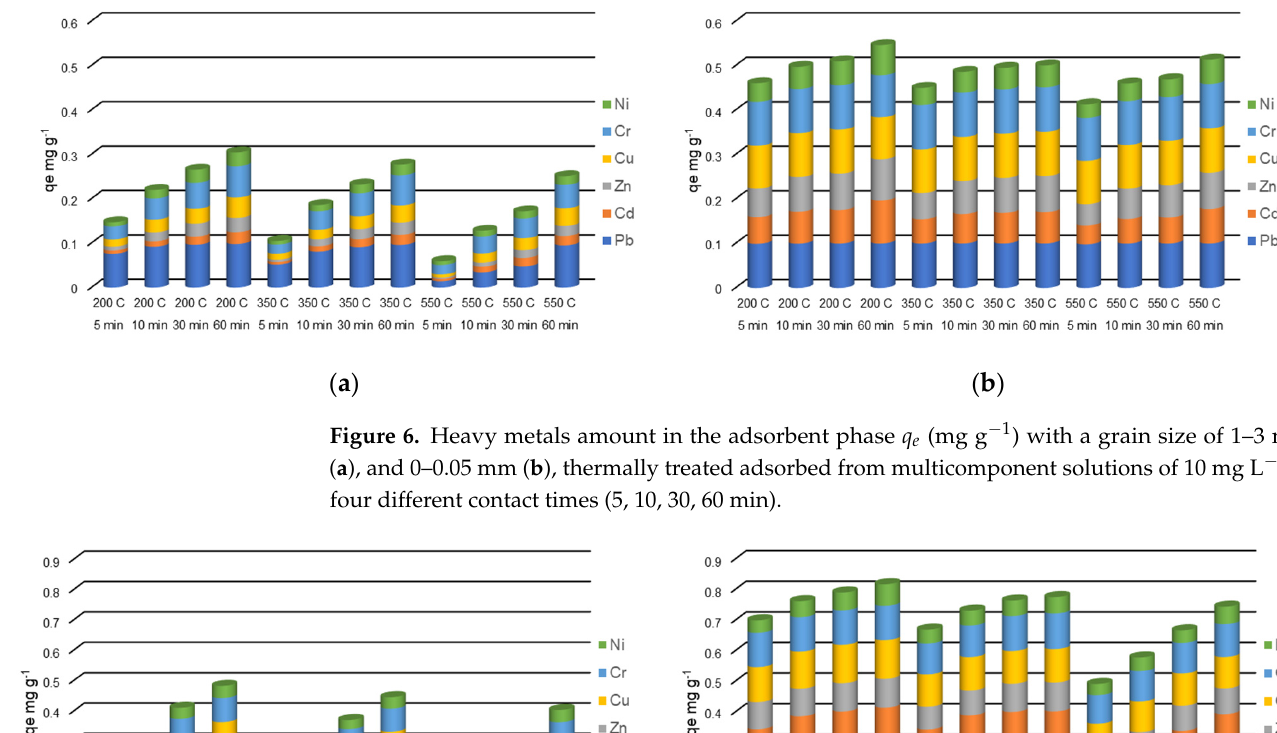
Figure 5. Heavy metals amount in the adsorbent phase q e (mg g − 1 ) with a grain size of 1–3 mm ( a ), and 0–0.05 mm ( b ), thermally treated adsorbed from multicomponent solutions of 5 mg L − 1 at four different contact times (5, 10, 30, 60 min).